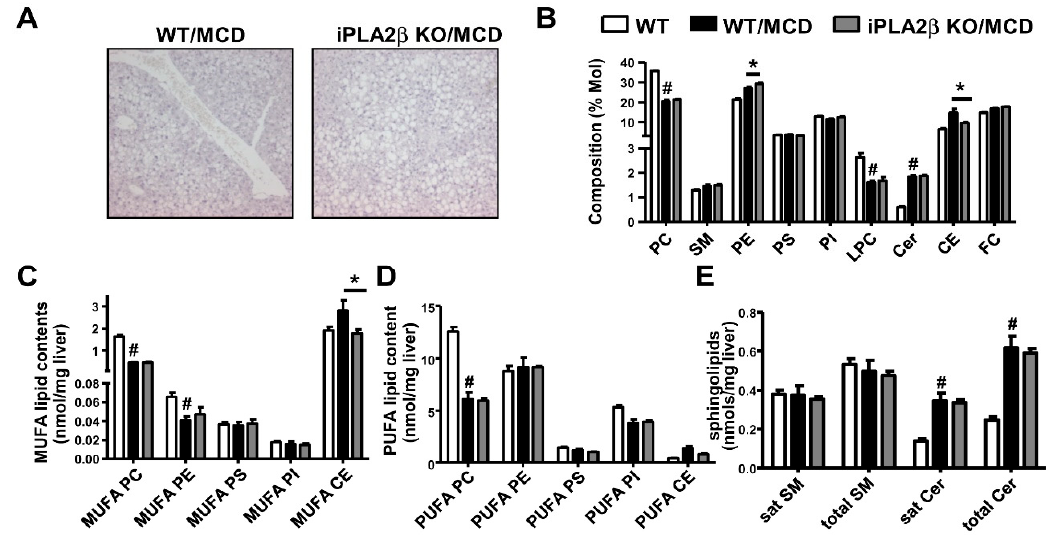
Figure 5. Inactivation does not rescue the defect of hepatic phospholipid remodeling in